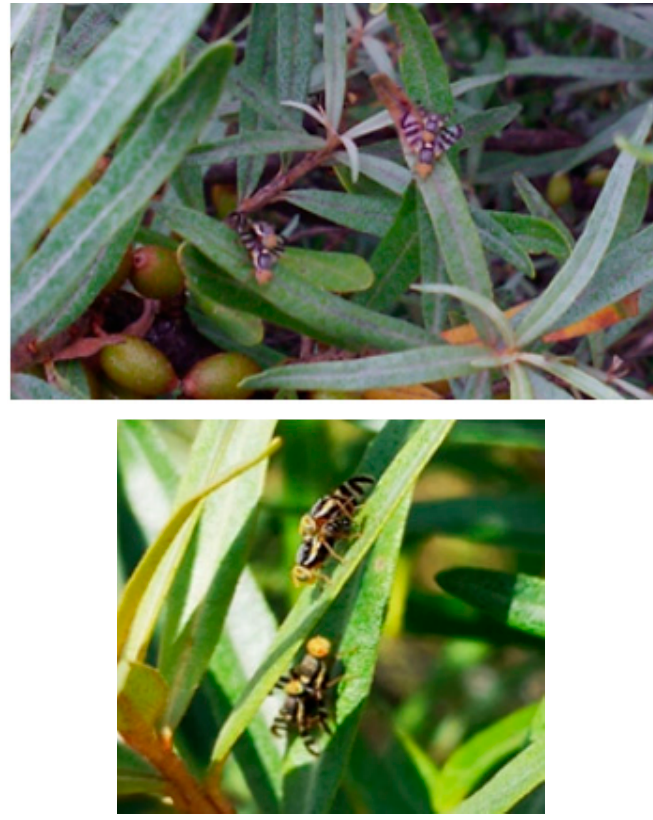
Figure 8. A few R. batava pairs in copula are commonly found near each other on adjacent leaves of a host plant Hippophae rhamnoides